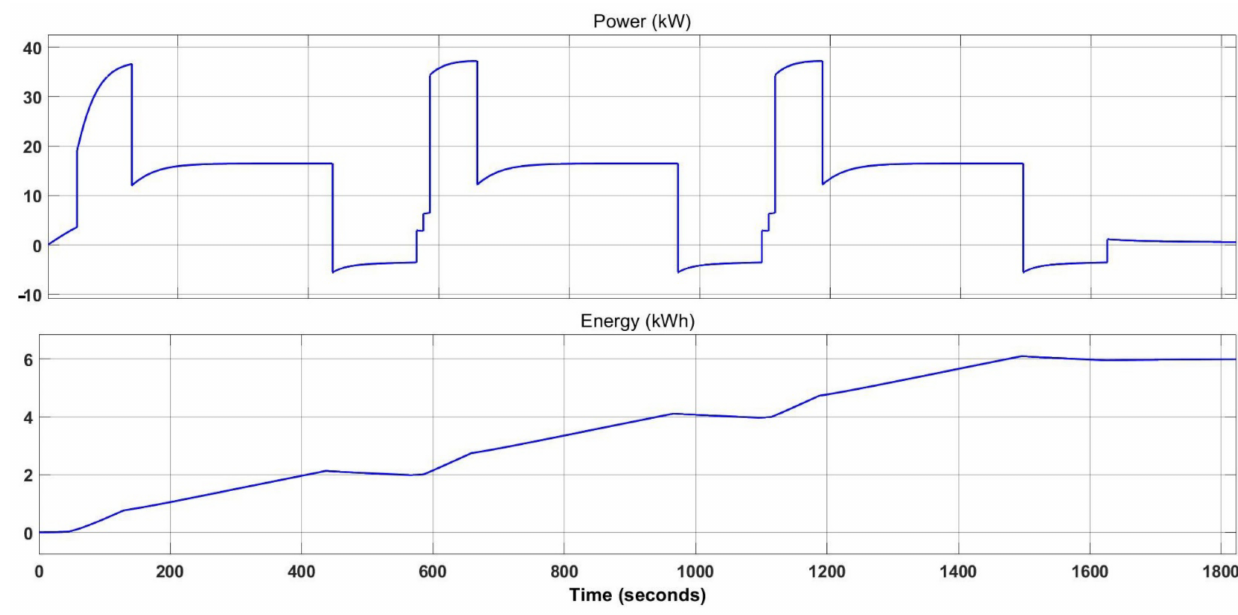
Figure 9. Power demand and energy consumption of electric WT-9 Dynamic—touch-and-go proce- dure.